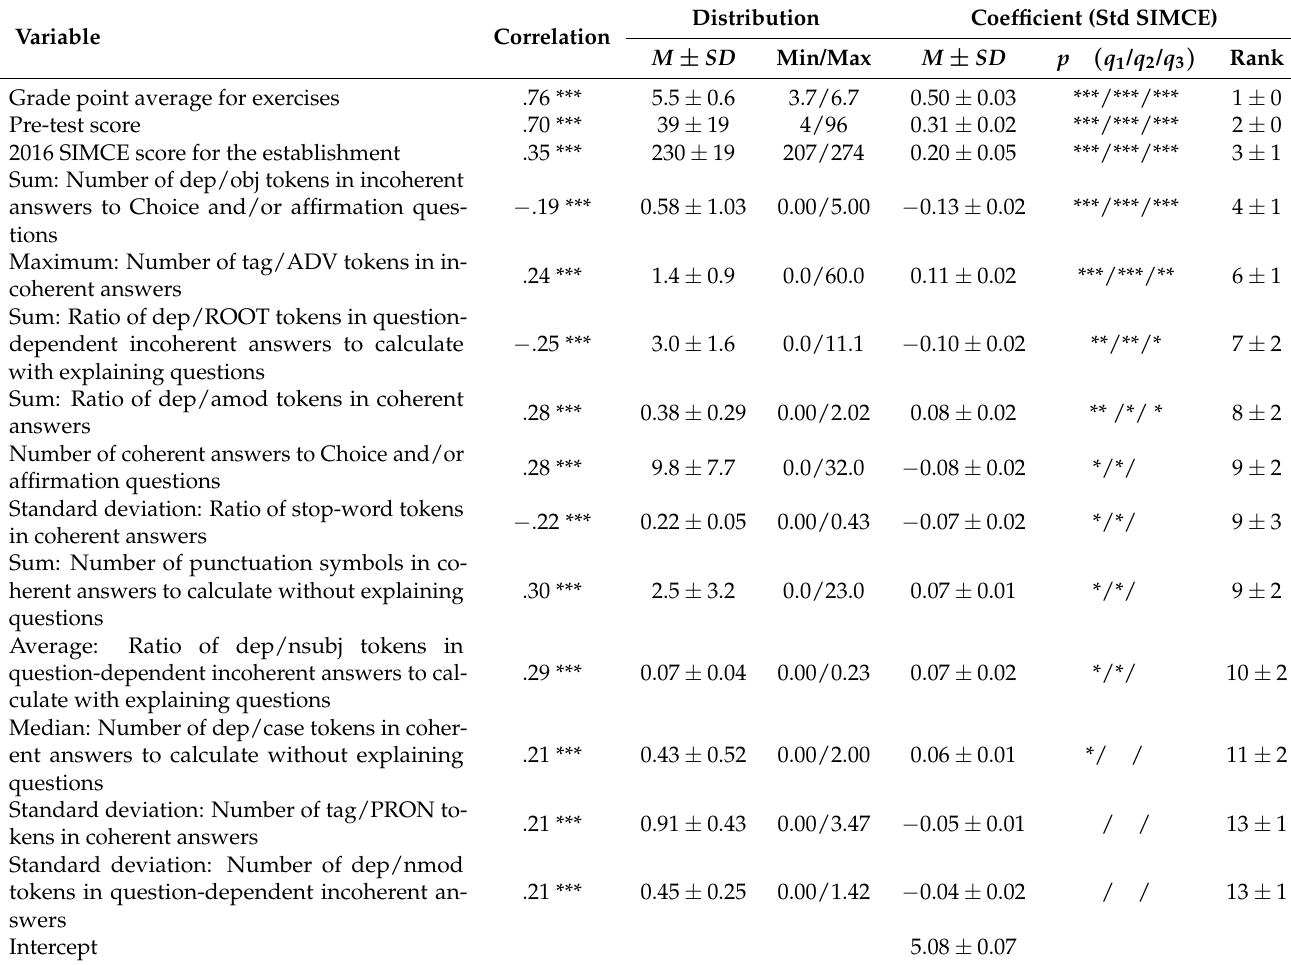
Table 4. Description of regressors for the Open-ended model. Correlation corresponds to the Pearson coefficient between the regressor and SIMCE score. Coefficient is the average value of the coefficient associated with the regressor divided by SIMCE standard deviation (47.80 reported in Ulloa Miranda 2021). Rank is the average value of the relative weight (less is better) of the modulus of the coefficient associated with the regressor for each fitted model. Both the Coefficient and the rank are obtained from 250 four-fold